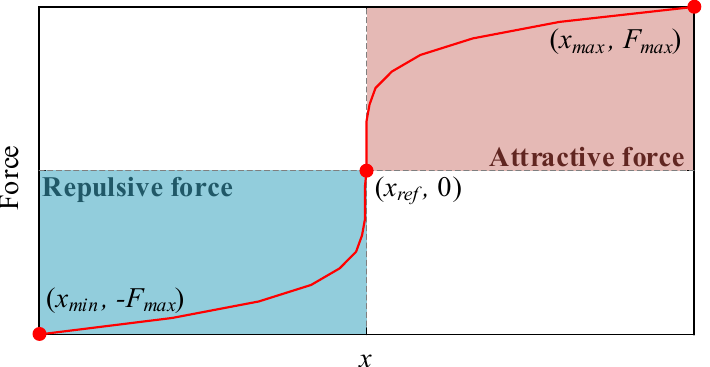
Figure 4. The force function of artificial potential field